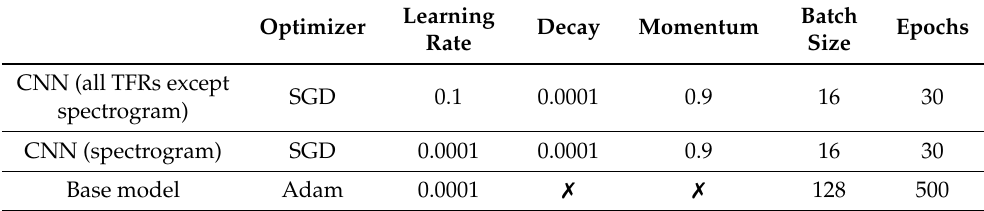
Table 2. Training parameters that were used for the